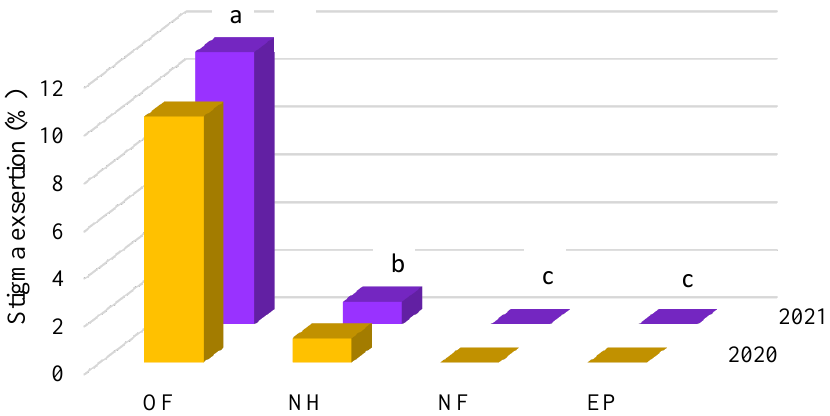
Figure 8. The percentage of flowers with exserted stigmas during the peak flowering period in relation to reduced heat stress by modifying walk-in tunnels (net house, NH; net house with fogging, NF, operating 6 S/36 S from 10 a.m. to 4 p.m.; and evaporative cooling under plastic house, EP) compared to open-field growing (OF). Different letters above the bars indicate that means are significantly different ( p ≤ 0.05). Presented data are the mean of 3 biological replicates, each with 5 plants.